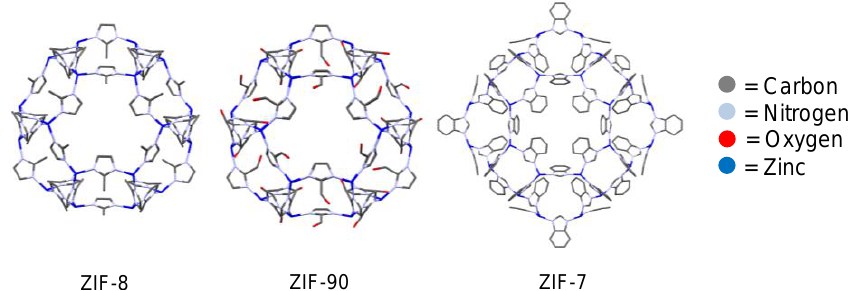
Figure 15. Structures of ZIF-8, ZIF-90 and ZIF-7, hydrogen atoms have been removed for clarity. Structures generated from crystal structure data [42].